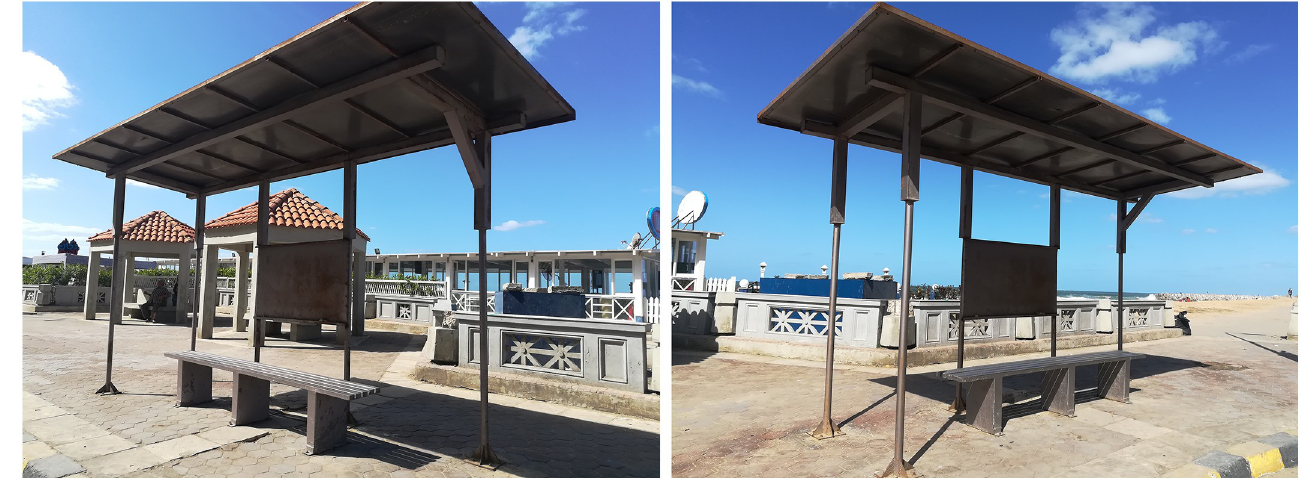
Fig 12. The bus stop at Cleopatra Station poor conditions as an illustration for other bus stops’ conditions. (Researcher, 2018).